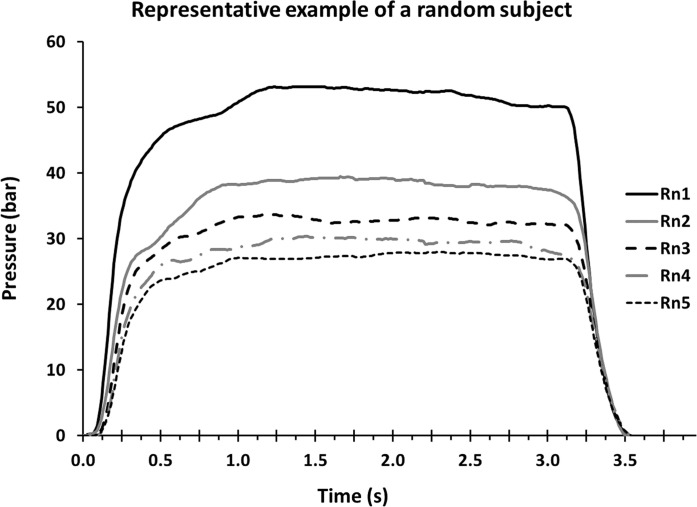
Example of P-t curve from a representative subject during five maximal voluntary contractions (MVC), each corresponding to one of the five normalized rounds (Rn) of the intermittent fatiguing protocol (IFP).